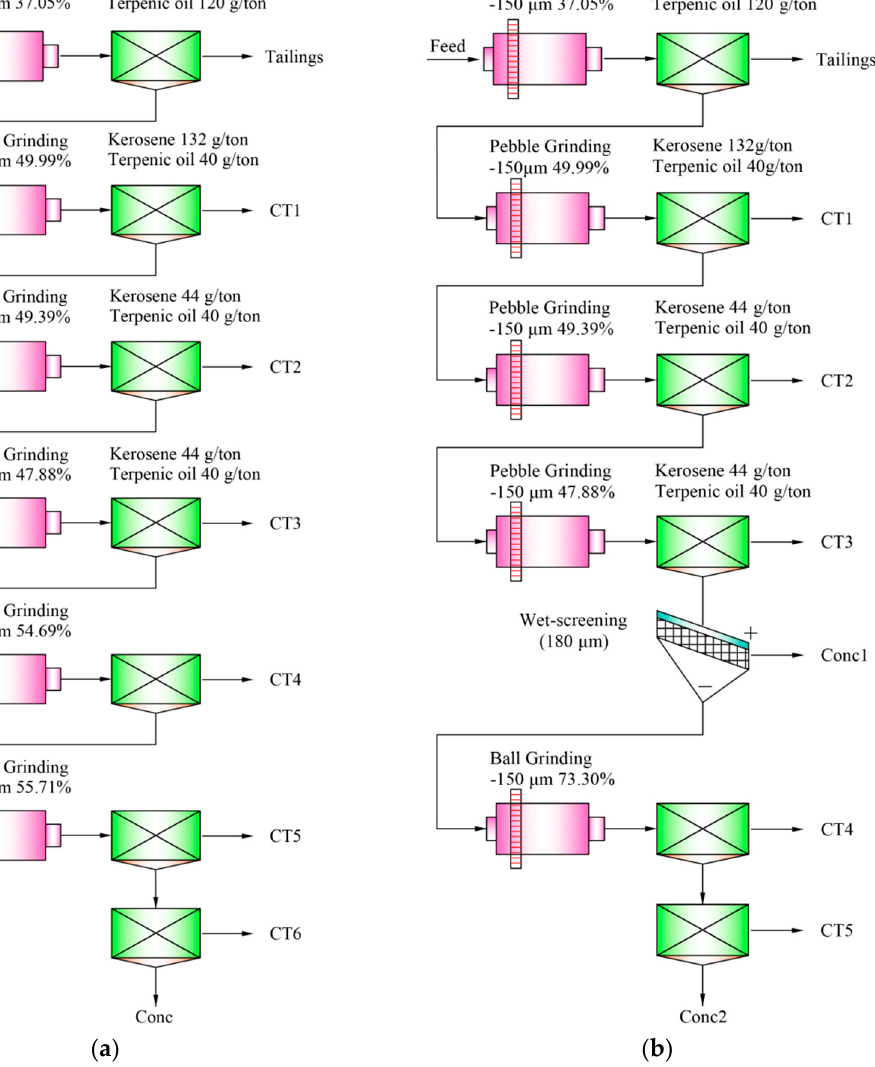
Figure 7. Flowcharts of ( a ) the conventional open circuit and ( b ) the modified open circuit.